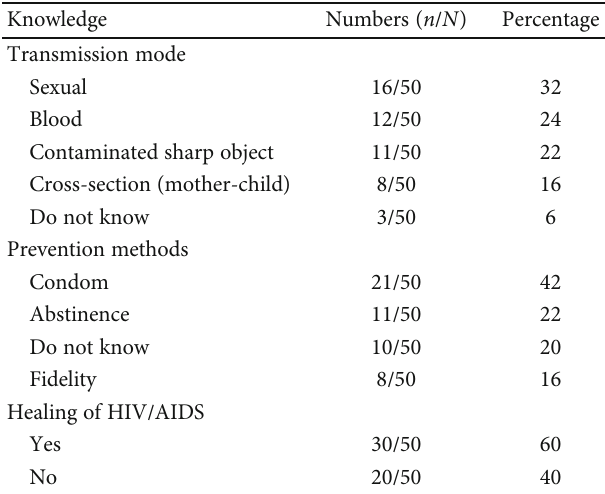
Table 2: Distribution of respondents by knowledge of HIV/AIDS ( N = 50